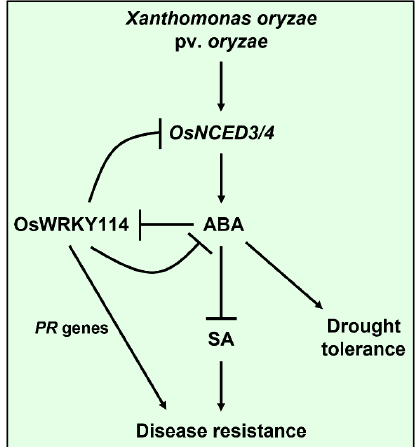
Figure 7. A working model of OsWRKY114 in innate immunity to Xanthomonas oryzae pv. oryzae. OsWRKY114 enhances disease resistance to Xoo through both upregulation of PR genes and down- regulation of the negative effect of ABA on SA-dependent immunity in rice. However, since ABA is a major phytohormone associated with abiotic stresses, the inhibition of ABA signaling by OsWRKY114 can reduce drought tolerance.